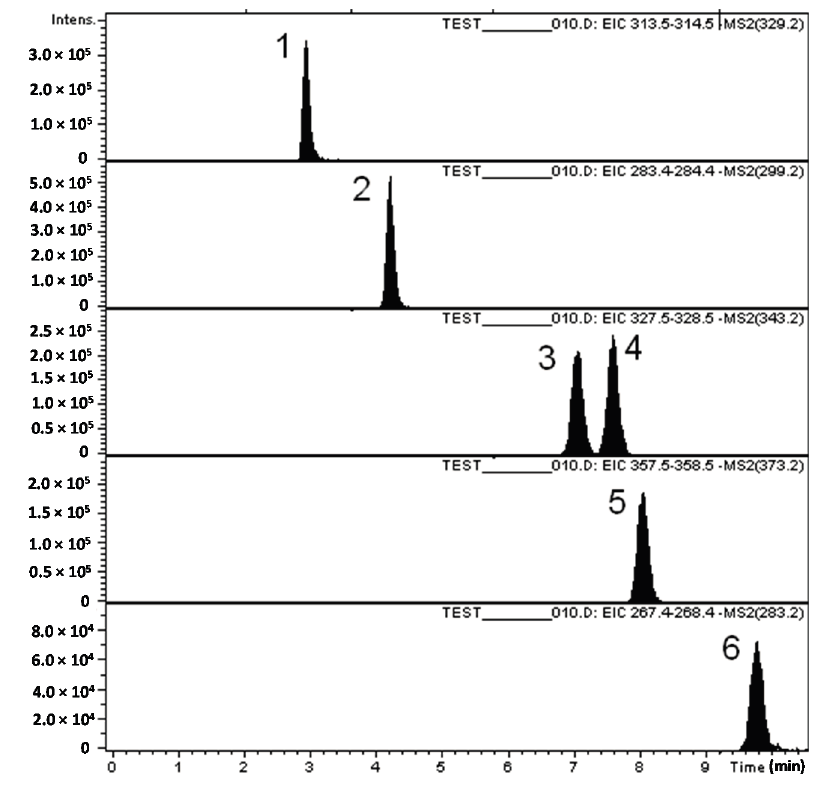
Figure 2. Tipical chromatogram of the six analyzed flavones: (1) jaceosidin; (2) hispidulin; (3) eupalitin; (4) eupatorin; (5) casticin and (6) acacetin.